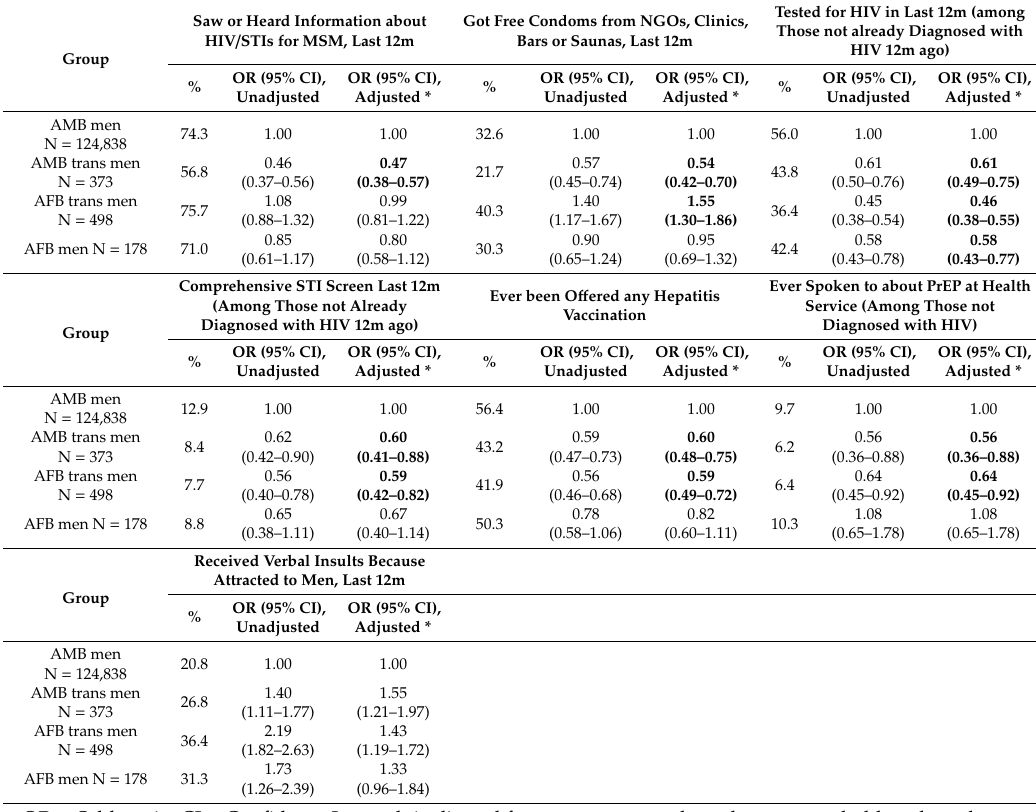
Table 5. Exposure to (positive sexual health and negative homophobic) interventions among four sex-assigned-at-birth / current-gender-identity subgroups of MSM. Tested for HIV in Last 12m (among Saw or Heard Information about Got Free Condoms from NGOs, Clinics, Those not already Diagnosed with HIV / STIs for MSM, Last 12m Bars or Saunas, Last 12m HIV 12m Group